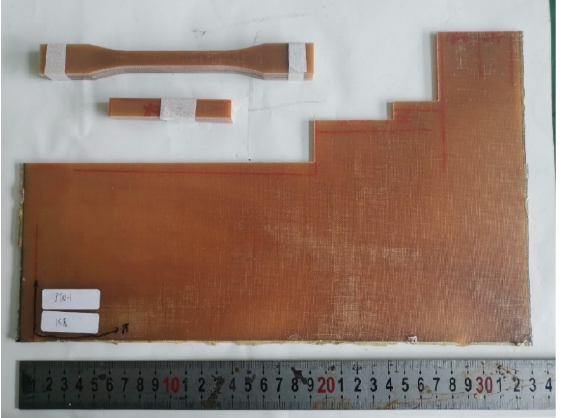
Figure 4. Ramie fiber green composites manufactured by ex-situ LCM.